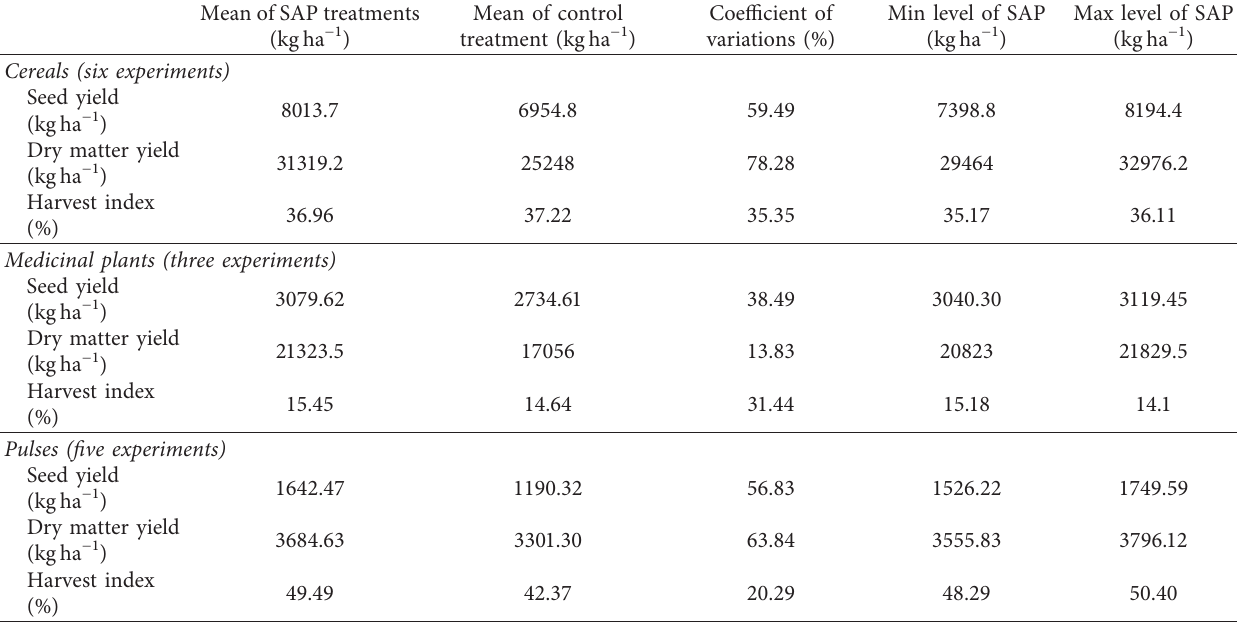
Table 3: Means of the studied traits for three crop families as a result of different levels of superabsorbent application. Mean of SAP